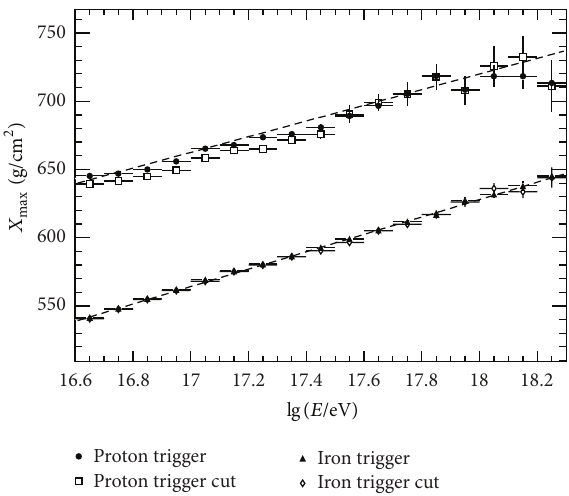
Figure 9: 𝑋 max distribution as a function of energy. Two lines are for primary proton and iron. Solid points are triggered events without any cut. Opened points are for events after cut1 described in Section